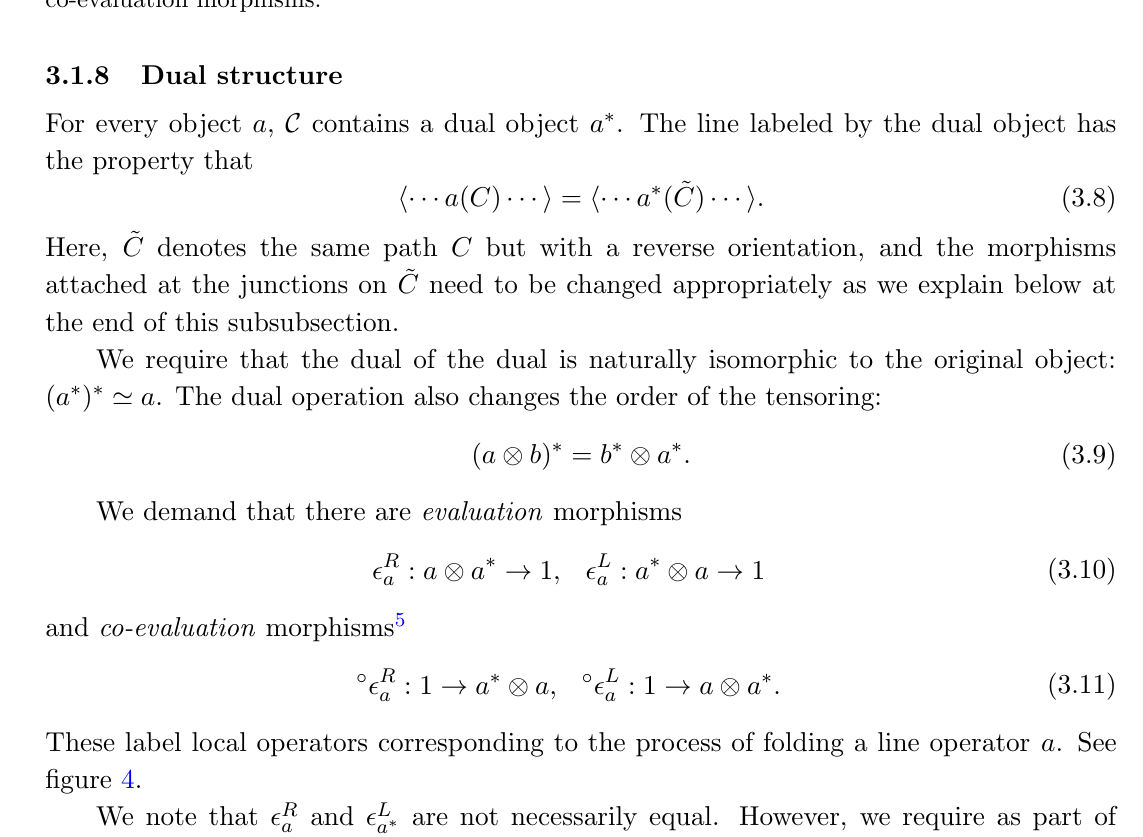
Figure 4 . Folding a line and squeezing it gives rise to local operators labeled by evaluation and co-evaluation